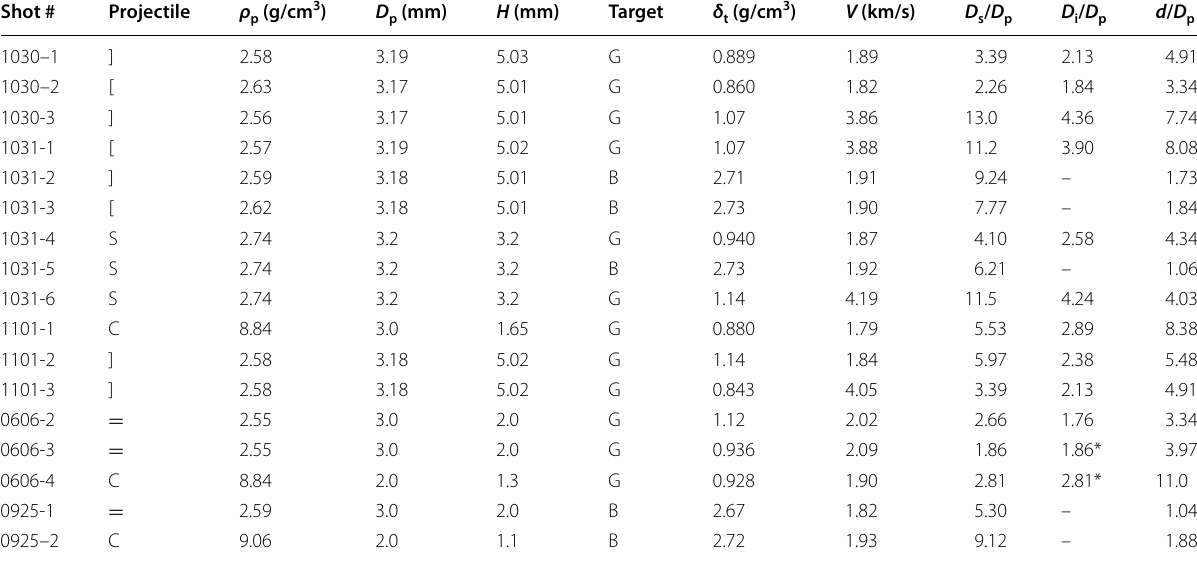
Table 1 Experimental conditions and results